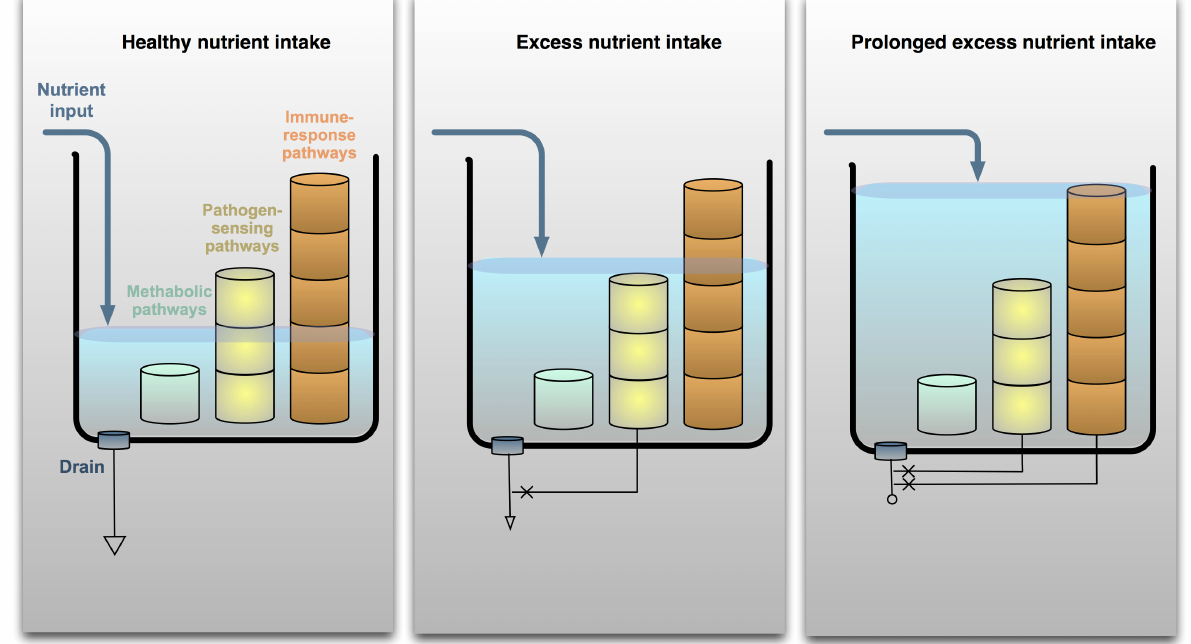
Figure 2. Nutrient overload signals spill from metabolic pathways to immune-response pathways. Nutrient input under normal or healthy conditions should engage metabolic pathways within the cells, leaving immune-response pathways inactive. With increased nutrient intake, the levels of nutrients flooding the system may rise enough that the overflow stimulates pathogen-sensing pathways. Because these pathways recognize biological molecules such as specific fatty acids, excessive amounts of nutrient moieties may also be able to activate such sensors. Once the immune sensors are activated, they may be antagonistic to the metabolic pathways, in effect blocking the drain of nutrient metabolism. If the nutrient excess persists to an extreme state, immune-response pathways of specialized immune cells may also be activated. The involvement of these pathways will intensify the inhibition of metabolic pathways and contribute to the backlog of nutrients in the system